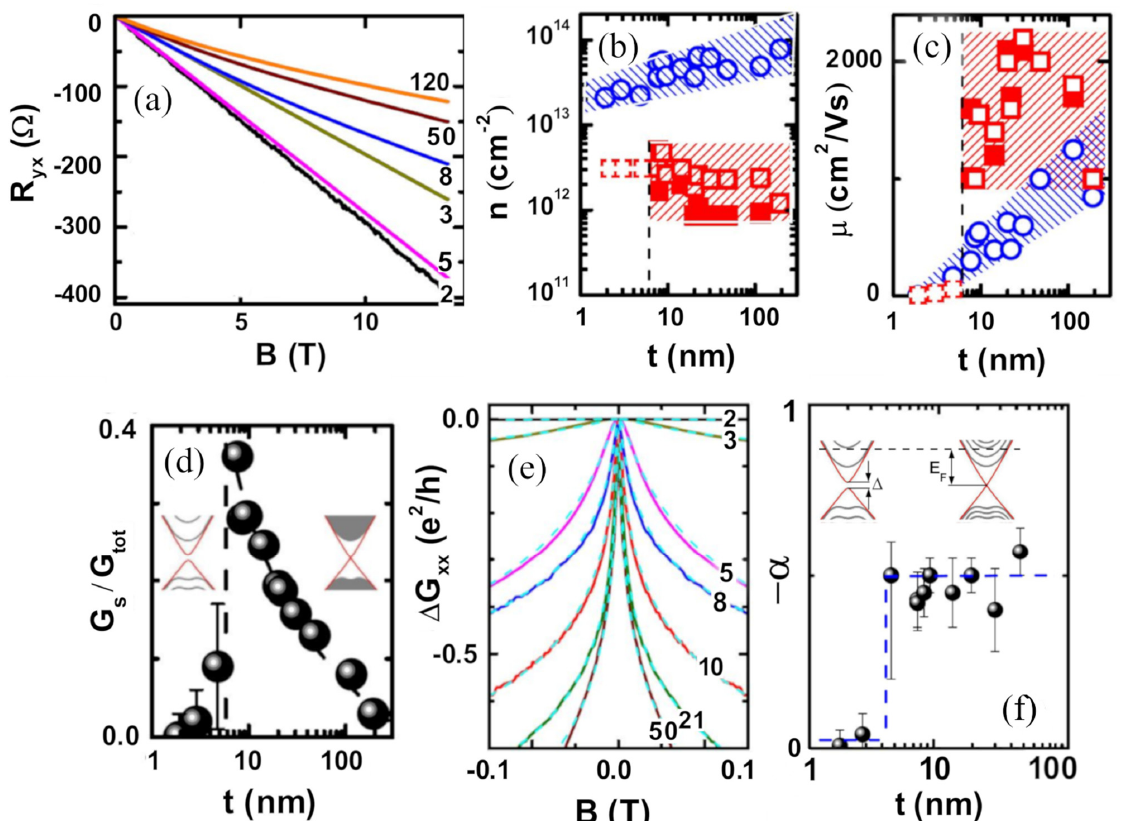
Figure 6. ( a ) Hall resistance against magnetic field for Bi 2 Se 3 films with different thicknesses (indicated in QLs on the right part of the plot) showing the non-linear dependence. ( b ) Carrier densities obtained from the SdH oscillations against thickness. ( c ) Mobilities obtained from the two-band analysis against thickness. In ( b ) and ( c ), the blue circles represent the bulk data ( n b , µ b ) and the red squares represent the surface data ( n s , µ s ) , where empty and filled squares represent the two different surfaces. ( d ) G s /G tot against film thickness. ( e ) 2D Magnetoconductance for different film thicknesses. ( f ) Value of α against film thickness. Inset in ( e ) shows schematic energy bands above and below the critical thickness. Data were taken at T = 1.6 K. Reprinted with permission from Reference [13]. Copyright 2012 American Physical